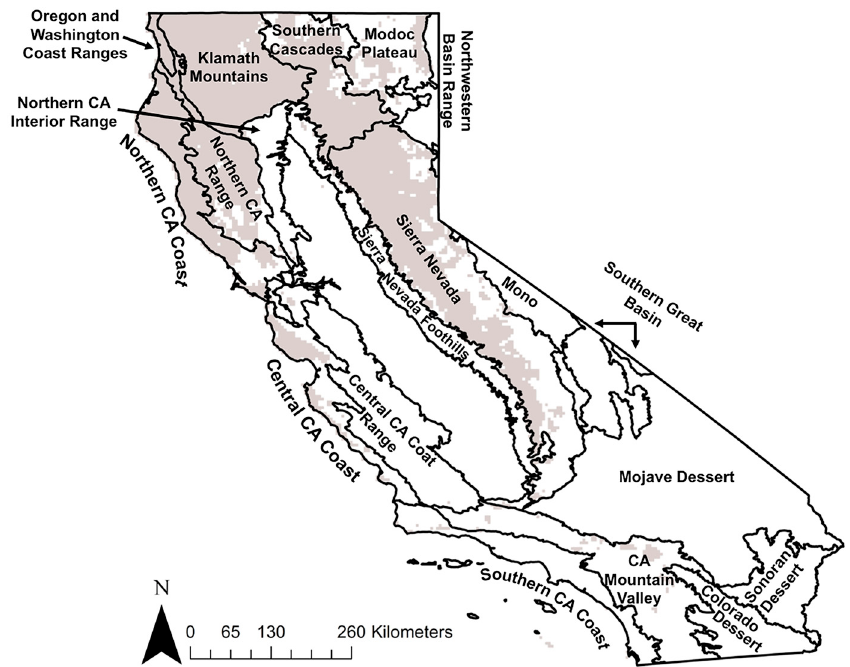
Figure 1. California’s distinct combinations of climate, elevation, and soil types create a unique mix of ecoregions and forest types. Forested areas are shown in grey and white areas represent non-forested land cover that was not included as part of this study. MODIS land cover type (MCD12Q1) in 2012 was used to identify forested areas [35]. The climate ecoregion layer was produced by the Forest Service Ecological Information and Mapping (ECOMAP) Team (https://data.fs.usda.gov/geodata).